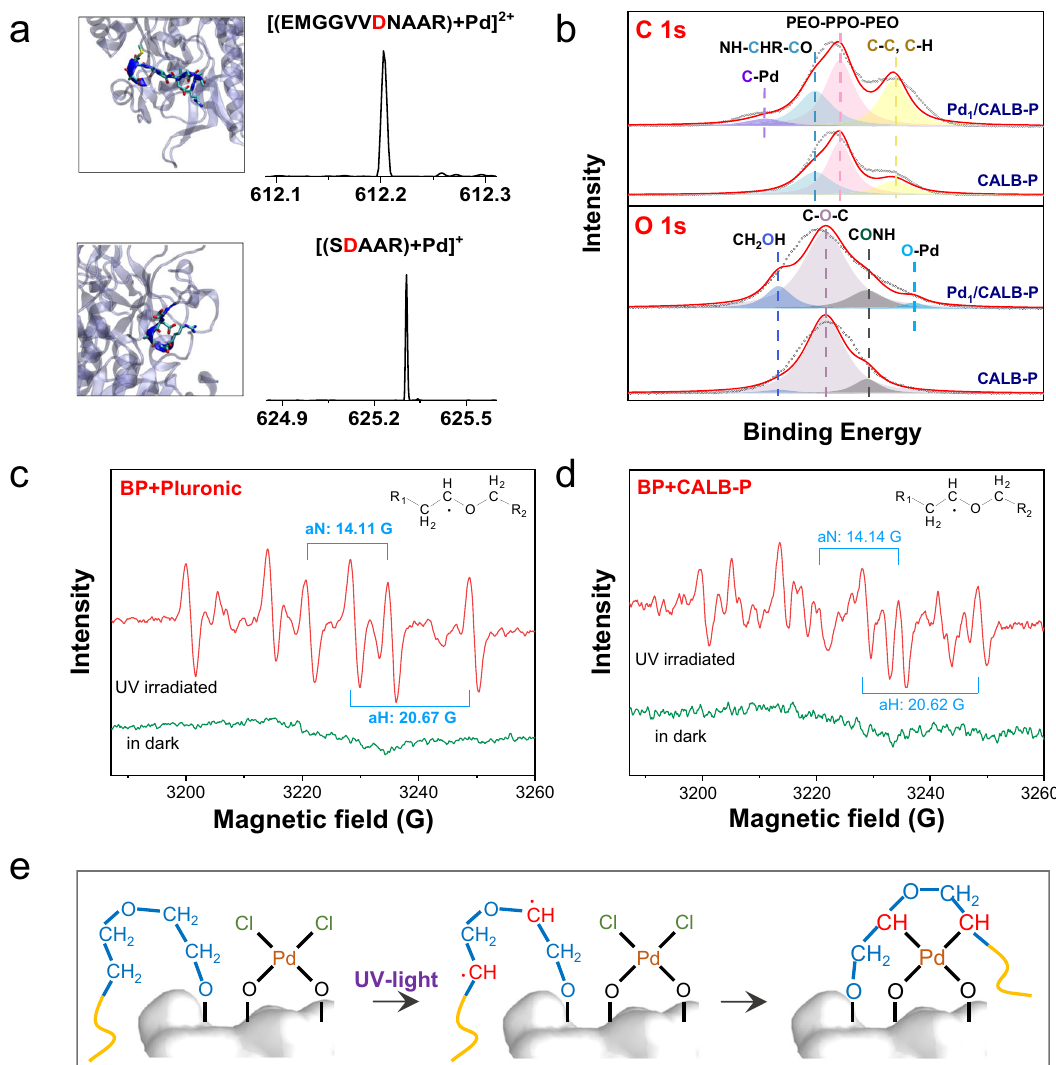
Fig. 2 Mechanism for the stabilization of Pd single atoms on enzyme. a The con fi gurations and mass spectra of peptides of enzyme that possibly coordinated with Pd single atoms. b High-resolution C 1 s and O 1 s XPS spectra of Pd 1 /CALB-P and CALB-P. ESR spectra of c , the mixture of BP and pluronic and d , the mixture of BP and CALB-pluronic after UV irradiation for 4 min or in dark in toluene. e Schematic illustration of the mechanism for the synthesis of Pd-anchored